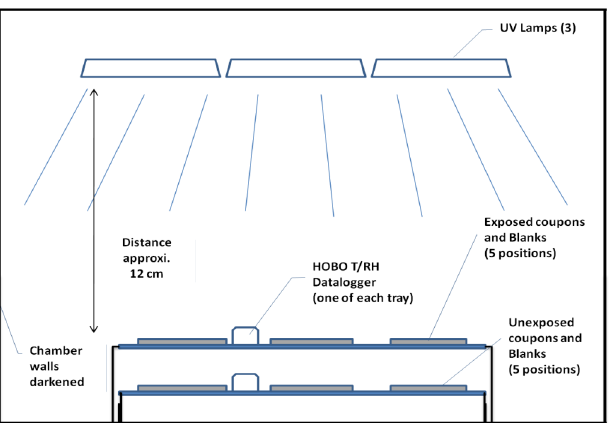
Fig 1. Test chamber schematic (not to scale). Exposed coupons were positioned in a single layer on top of the tray (lined with kraft paper to block UV radiation from hitting lower tray) with unexposed coupons positioned in a single layer underneath the tray supporting the test coupons. Unexposed coupons were also shielded from UV light exposure from the